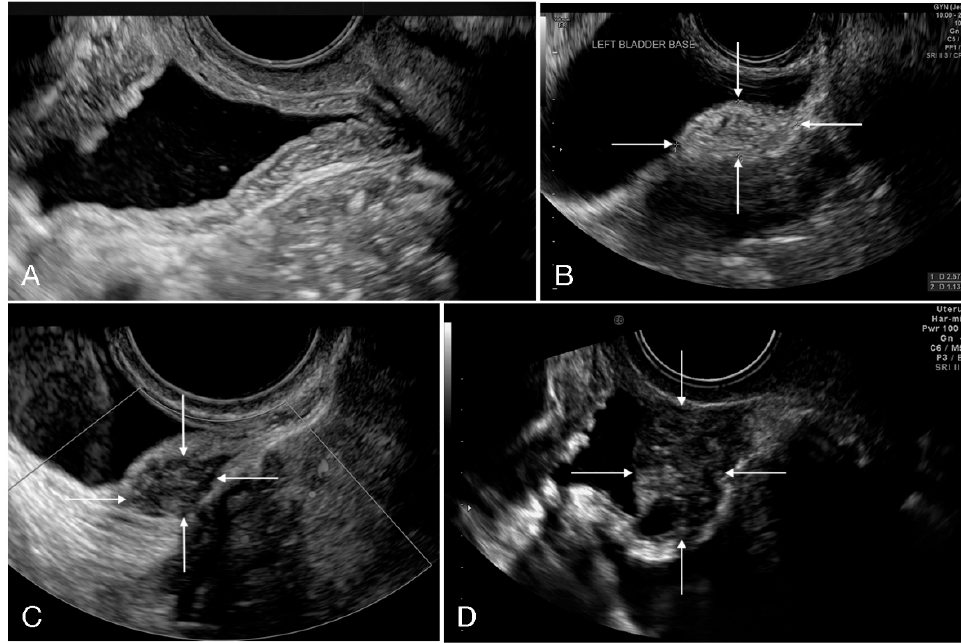
Figure 2. Transvaginal ultrasound depiction of the bladder. ( A ) Normal bladder and ( B – D ) three bladder deep endometriosis nodules, identified with white arrows.